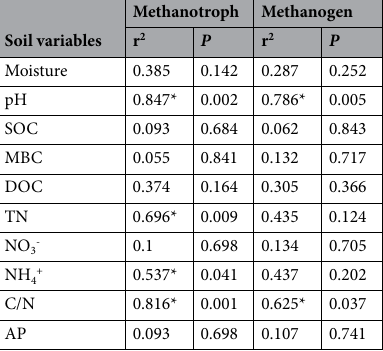
Table 2. Monte Carlo permutation test correlations between methanotroph and methanogen community structure and soil physicochemical properties. *Indicates significant effects ( P < 0.05).